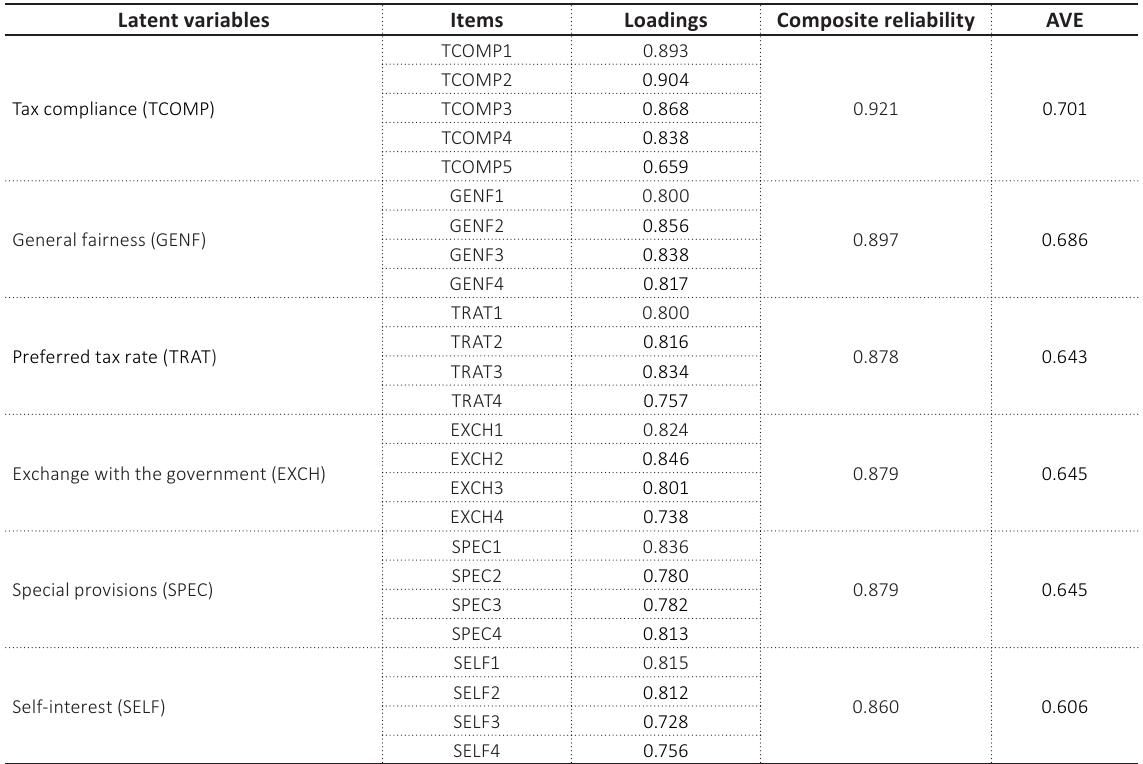
Table 1. Convergent